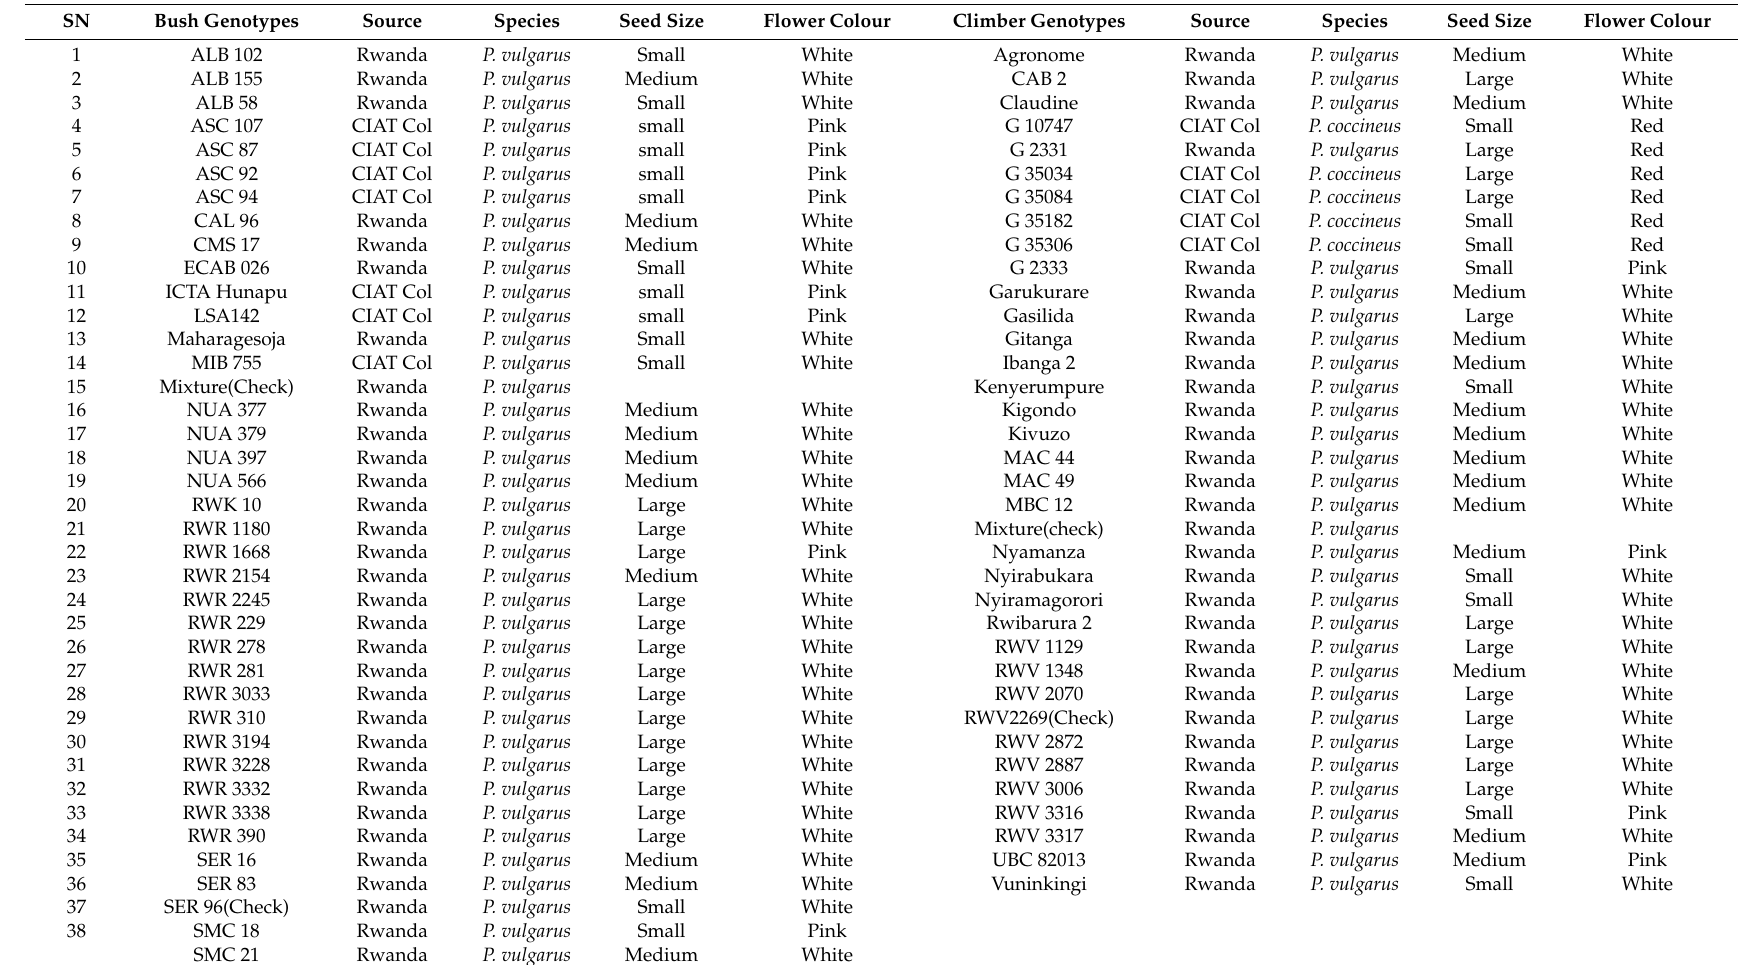
Table 1. List of bean genotypes used in the